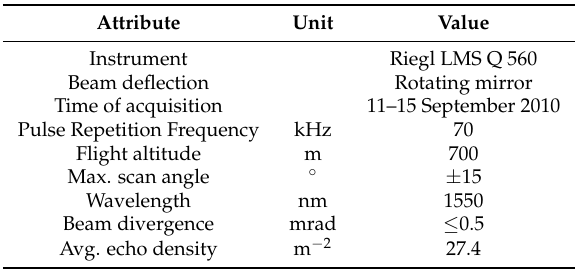
Table 3. Specification of the airborne LiDAR-data acquisition.